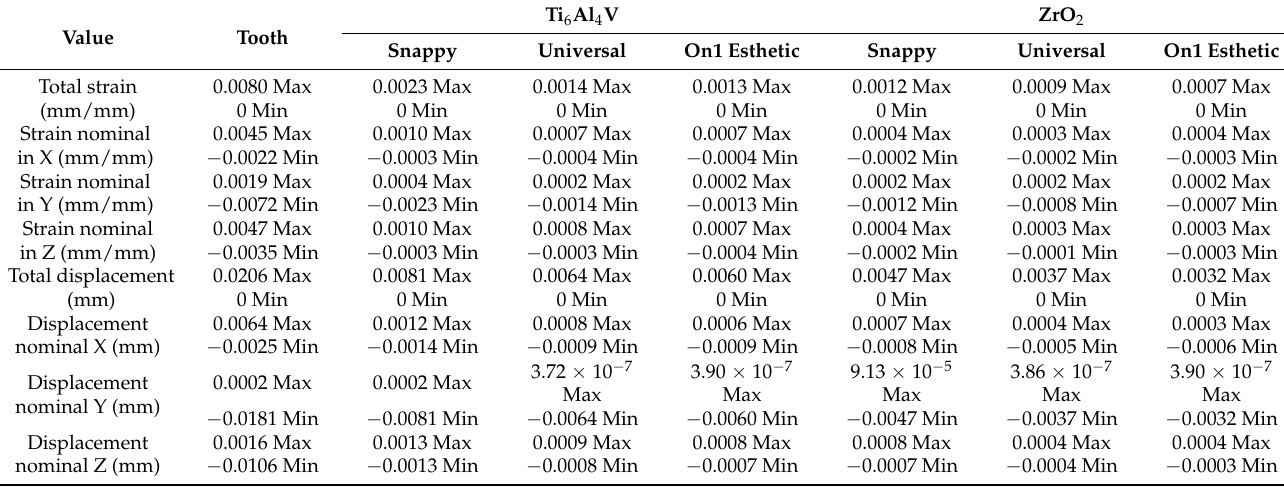
Table A1. Complete results obtained from the simulation in